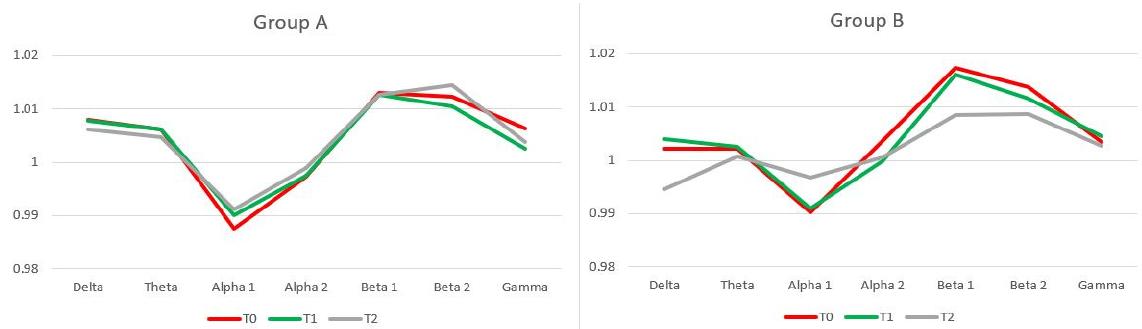
Figure 3. SW evaluation for two AD groups of two type of rehabilitation (repetitive Transcranial Magnetic Stimulation (rTMS) and Cognitive Training (Cog) for Group A and sham rTMS and Cog for Group B) for the evaluation of the effectiveness of the rTMS treatment before (T0), after the rehabilitation (T1) and at the 40 week follow up (T2). Adapted from [52].